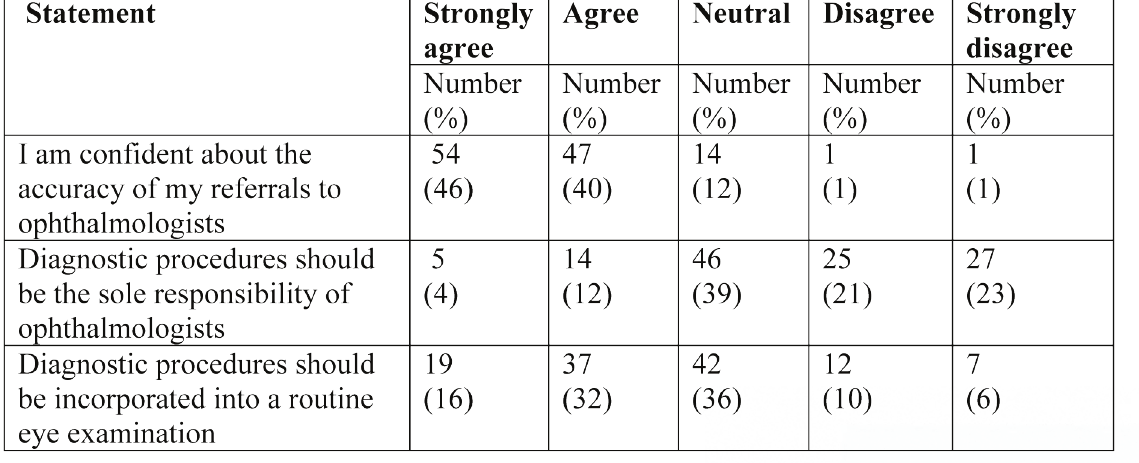
Table 3: The percentage of responses to various statements on referral and management practices are